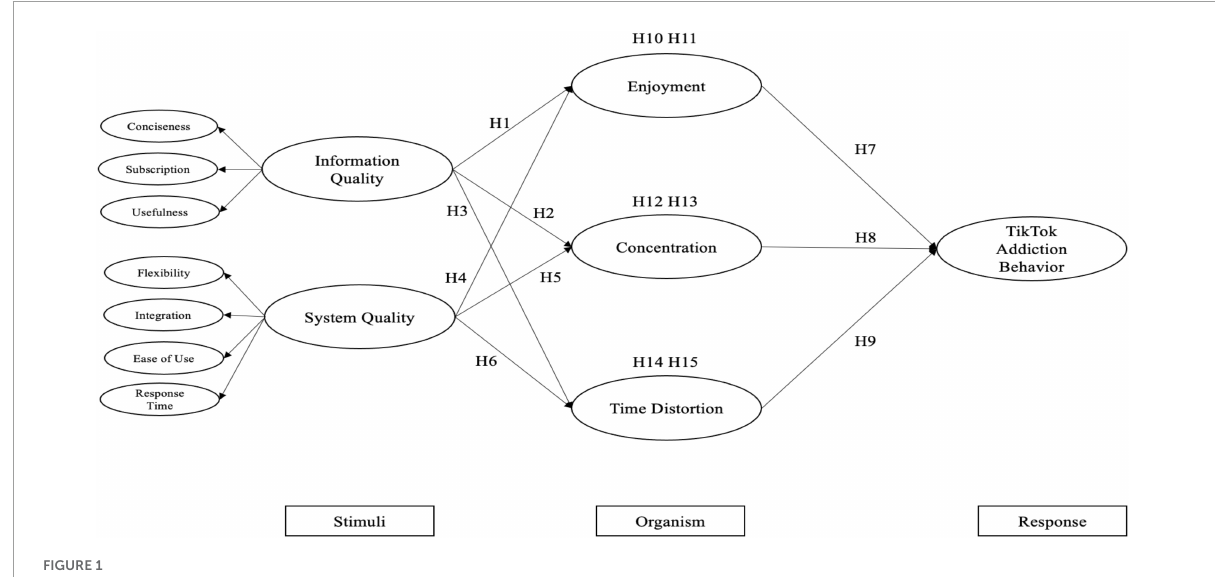
FIGURE1 The research